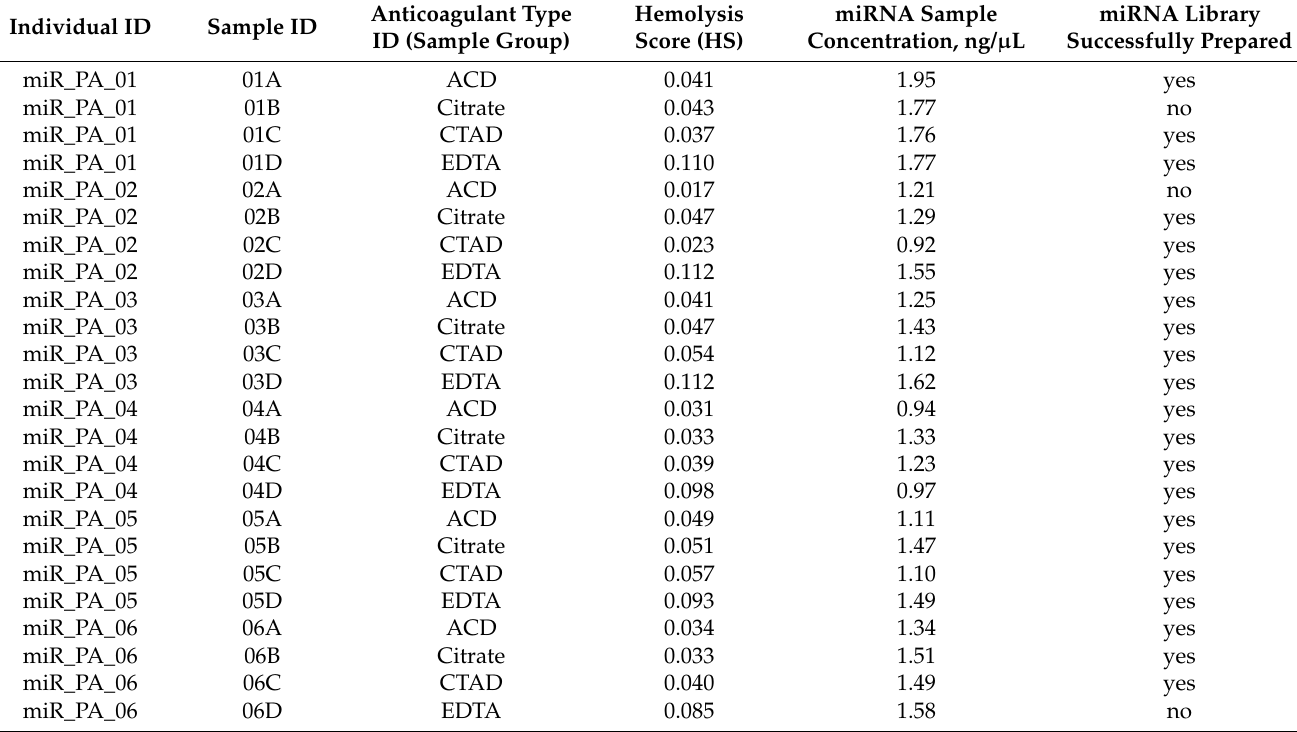
Table A1. Characteristics of biological